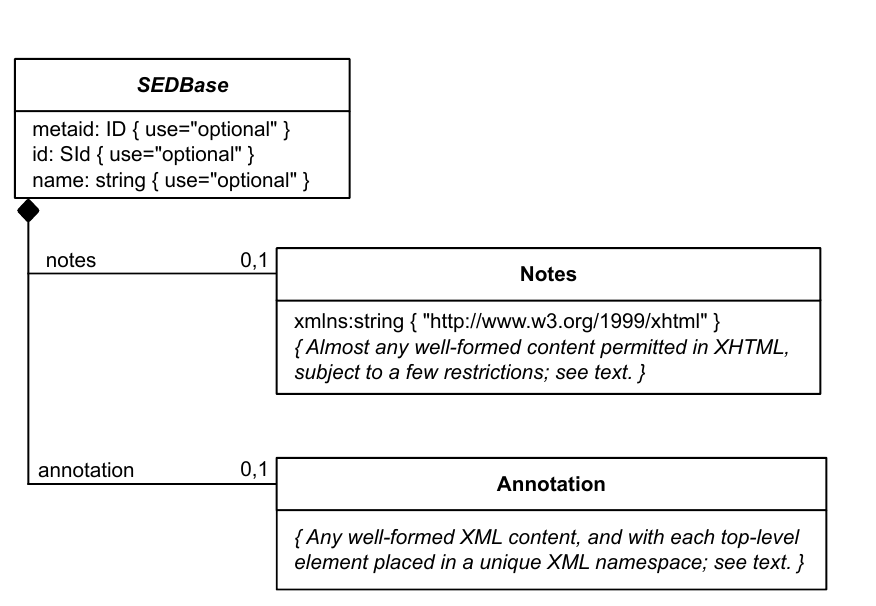
Figure 2.3: The SEDBase , Notes, and Annotation